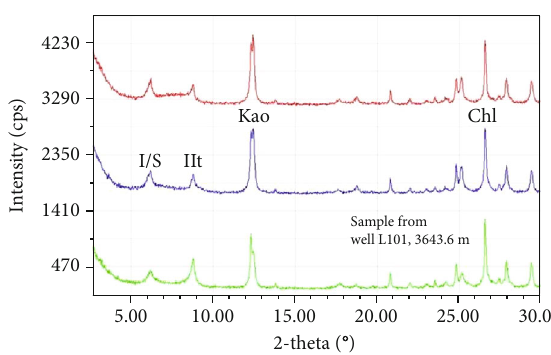
Figure 6: Representative clay fraction XRD spectra of the Es sandstone reservoirs in Raoyang Sag. Kao: kaolinite; Ilt: illite; I/S: illite/smectite; Chl: